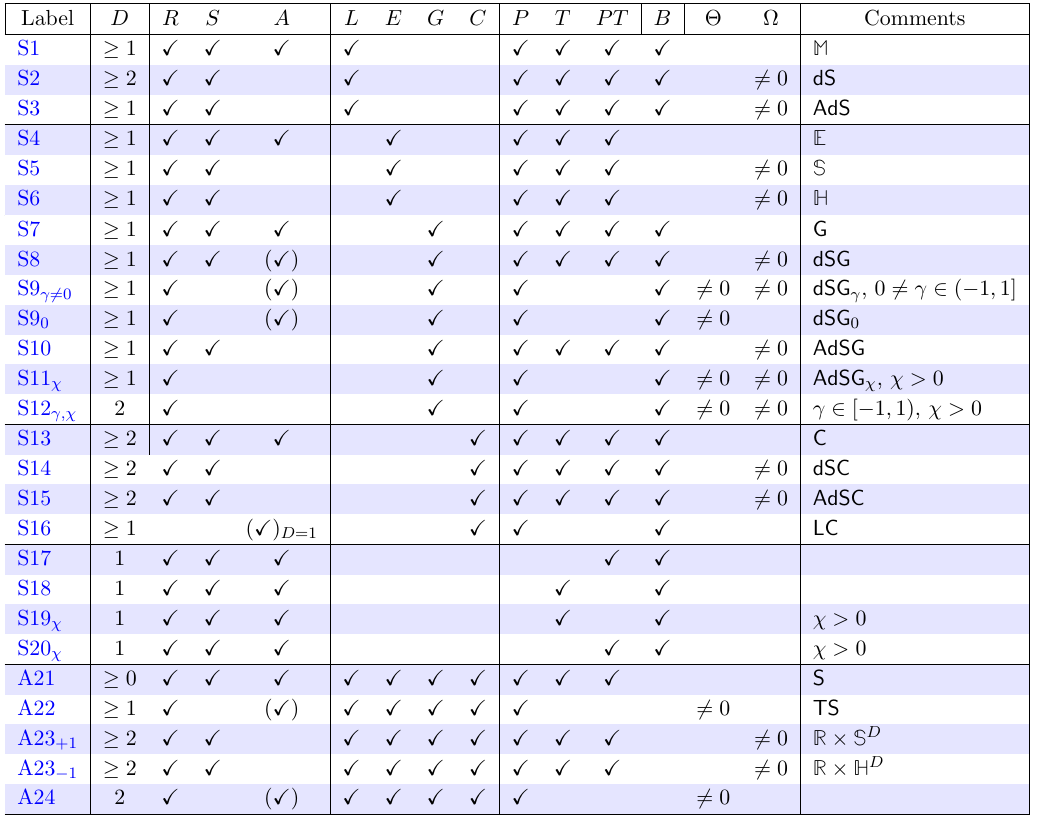
Table 3 . Properties of simply-connected homogeneous spacetimes. This table describes if a D + 1 dimensional kinematical spacetime (table 1) or aristotelian spacetime (table 2) is reductive (R), symmetric (S) or a(cid:14)ne (A). A spacetime might exhibit a lorentzian (L), riemannian (E), galilean (G) or carrollian (C) structure, and be invariant under parity (P), time reversal (T) or their combination (PT). The boosts (B) may act with non-compact orbits. Furthermore the canonical connection of a reductive spacetime might be have torsion ((cid:2)) and/or curvature